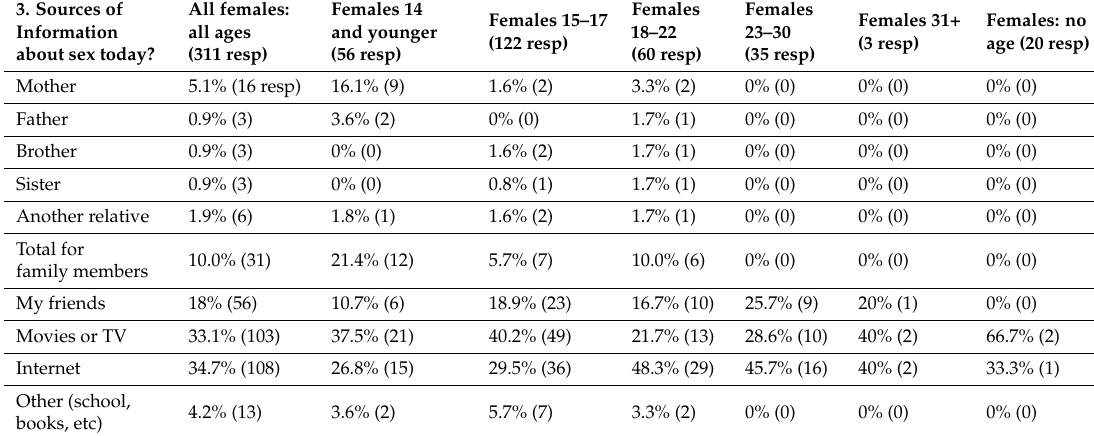
Table 4. Sources of Information about Sex—All